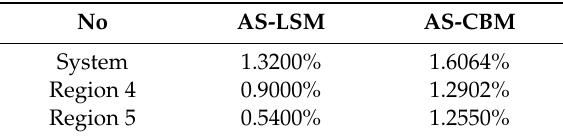
Table 6. The absolute error of probabilities for the system, region 4, and region 5 RoCoF by AS-LSM and AS-CBM within operational limits (correlated wind